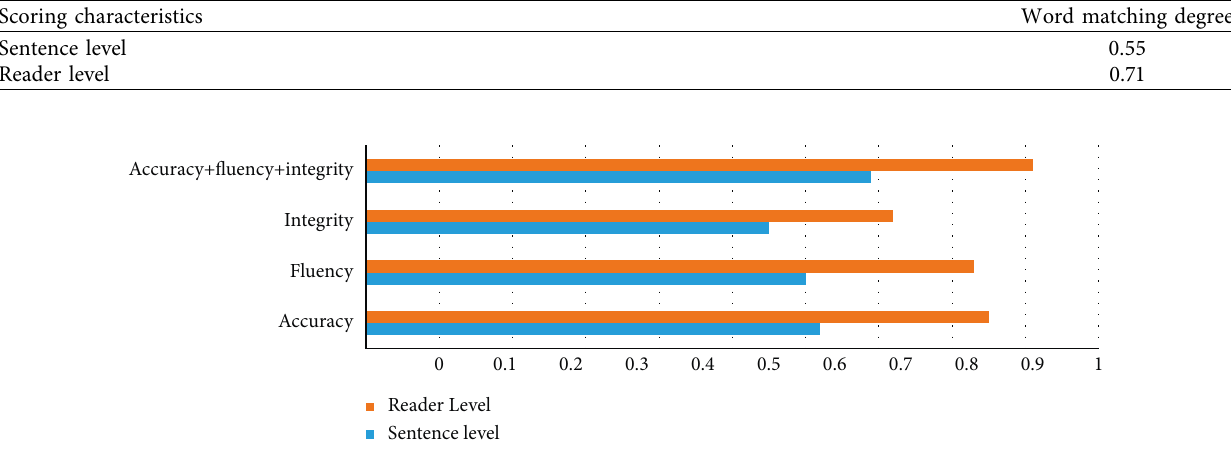
Figure 7: The pronunciation quality of reading aloud.